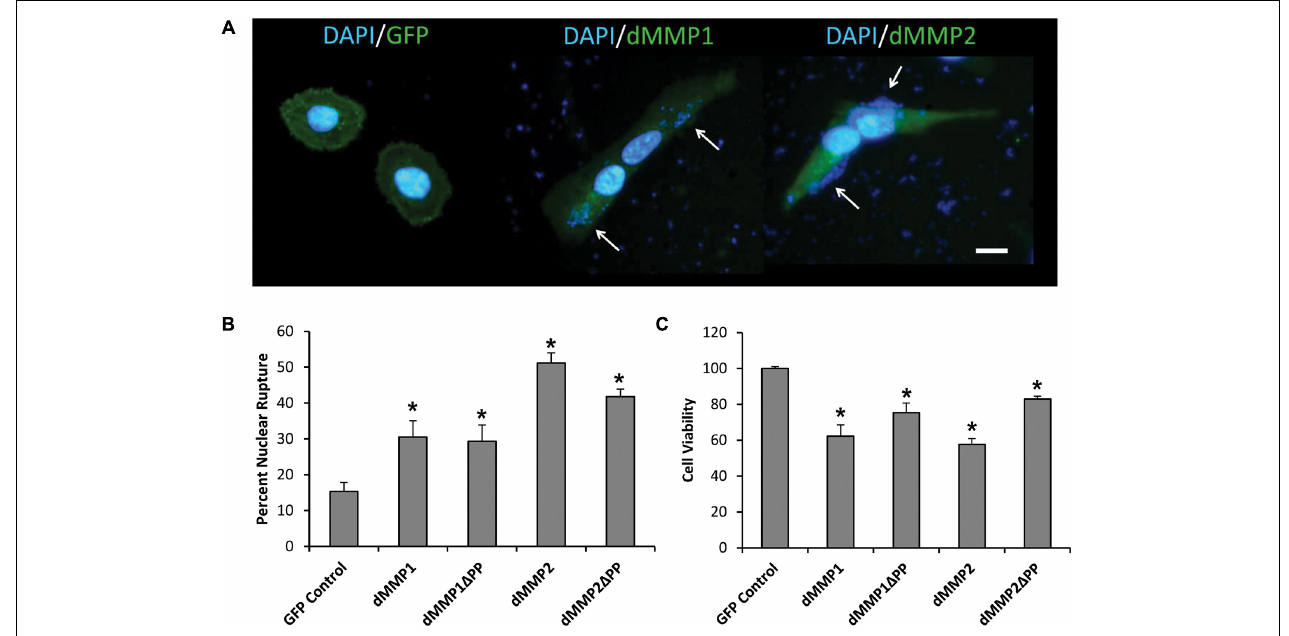
FIGURE 2 | dMMPs expression promotes nuclear rupture and reduces cell viability in neuronal cells. (A) SH-SY5Y cells lipofected with GFP, GFP-dMMP1, and GFP-dMMP2 shown in green and DAPI nuclear stain shown in blue. Arrows point to nuclear rupture. Scale bar is 10 µ m. (B) Percent nuclear rupture (Mean ± SE) in GFP and dMMP transfected cells. (C) Cell viability (Mean ± SE) in dMMP transfected cells normalized to GFP Control. Data are averaged across three independent experiments. Bars with * represents significant difference compared to control at p < 0.05.